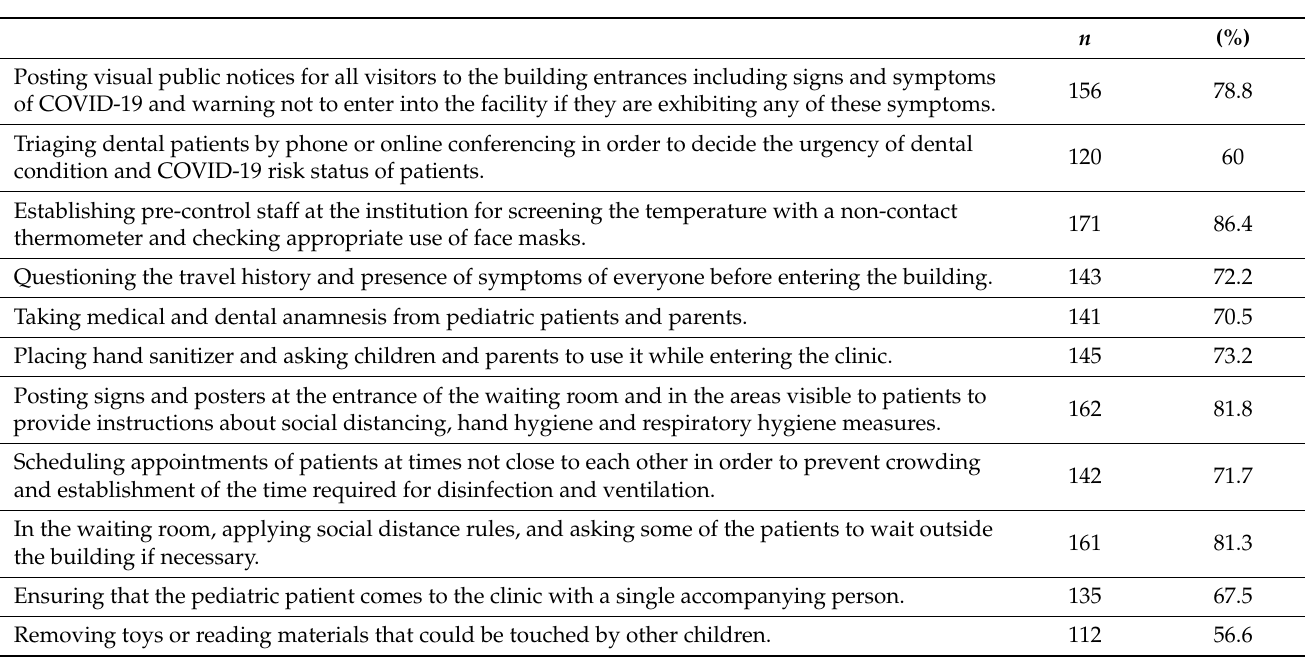
Table 5. Infection control practices used in institutions of participants before dental treatment.